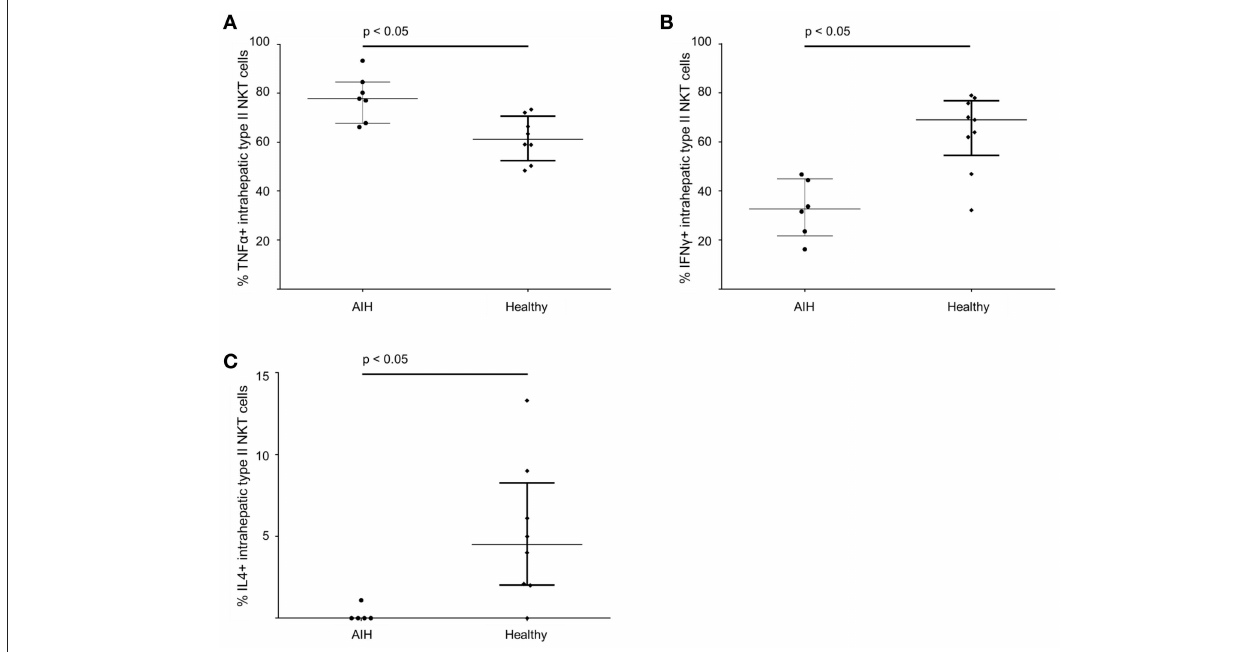
FIGURE 7 | Intrahepatic sulfatide-reactive type II NKT cells in patients with autoimmune hepatitis reveal a different cytokine profile than in healthy subjects. Intrahepatic type II NKT cells of AIH patients have an increased expression of TNF α (A) , a lower expression of IFN γ (B) and show a complete lack of IL-4 (C) compared to healthy subjects.